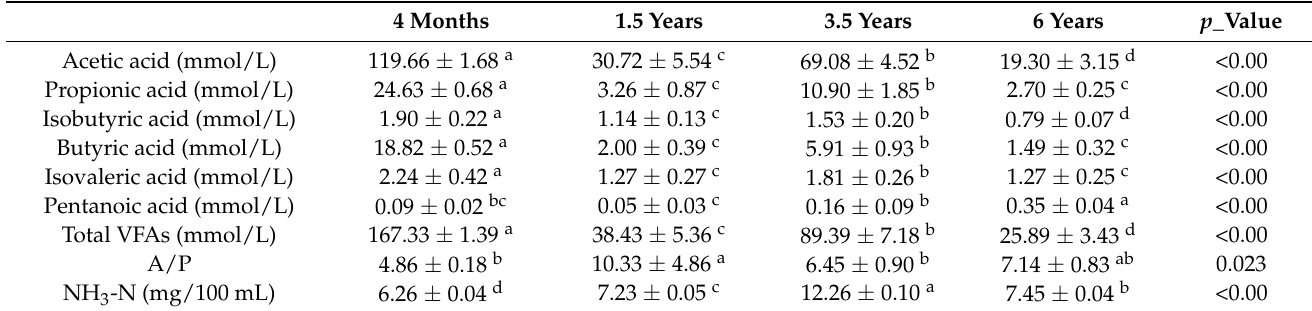
Table 1. Rumen fermentation parameters of Tibetan sheep at different